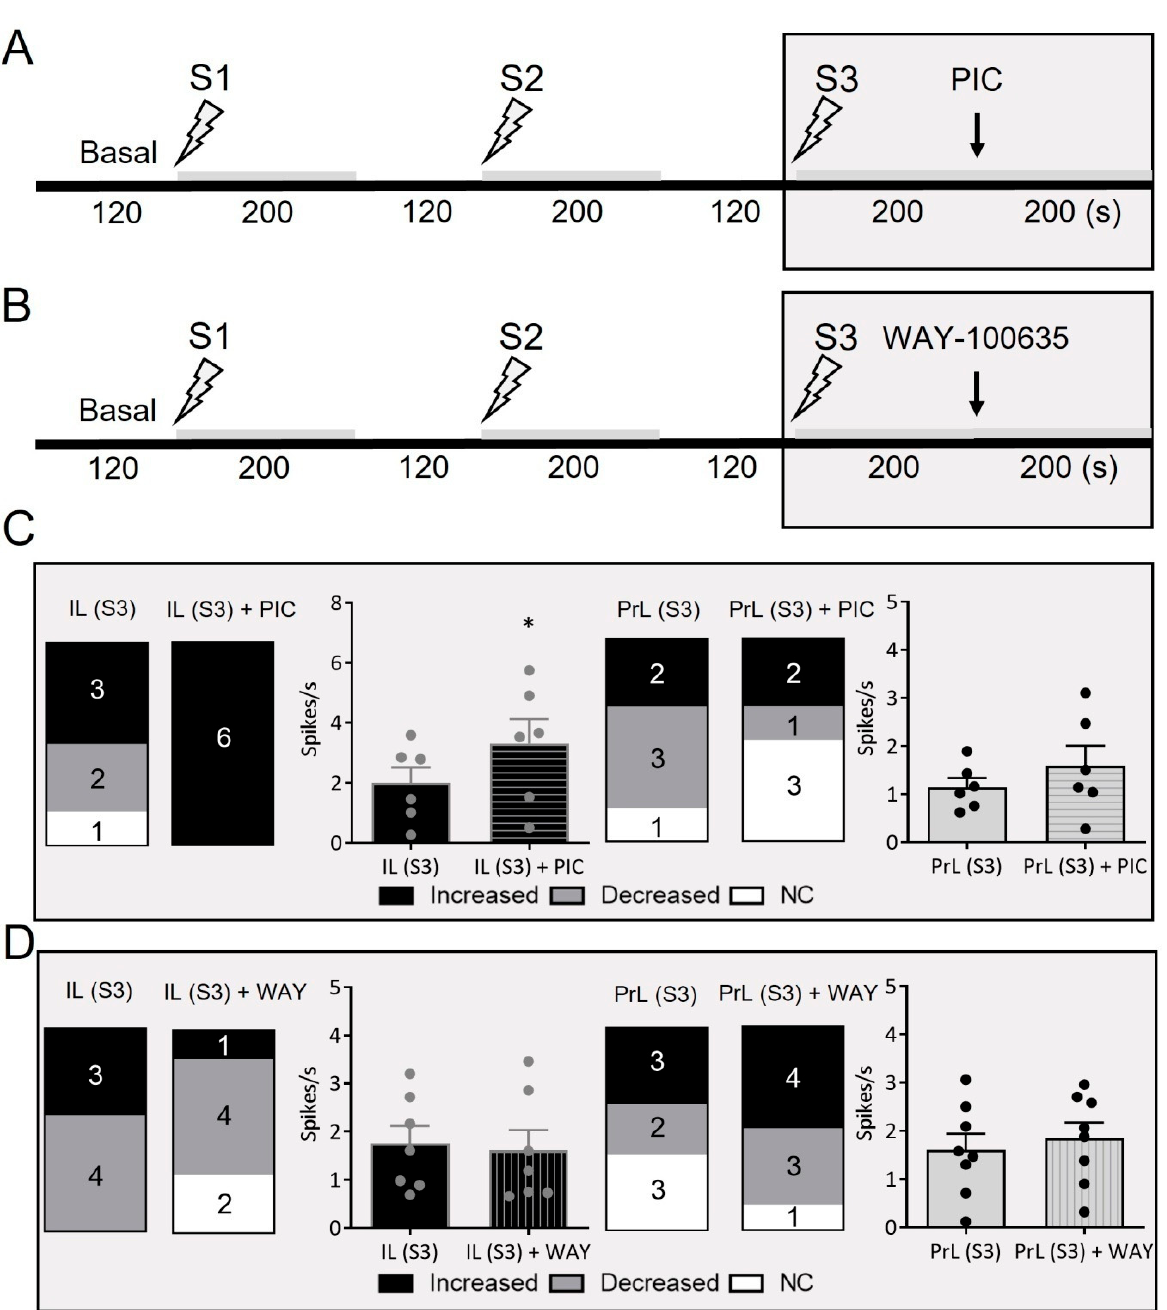
Figure 4. Involvement of 5-HT 1A and GABA A receptors in IL and PrL induced responses in DR 5-HT neurons. ( A , B ) Protocol used to examine the responses of DR 5-HT neurons to IL and PrL stimulation at increasing frequencies (S1: 0.9 Hz, 0.2 ms, 1.7 mA; S2: 10 Hz, 1 ms, 0.5 mA; S3: 20 Hz, 1 ms, 0.5 mA) before and during picrotoxinin (PIC, GABA A -R antagonist, 2 mg/Kg i.v.) ( A ) and WAY-100635 (5-HT 1A -R antagonist,10 µg/Kg i.v.) ( B ) administration. Note that both drugs were injected after S3, and the stimulation was maintained for at least 200 s more, to evaluate the effects of the drug. ( C , D ) Picrotoxinin (PIC) ( C ) and WAY-100635 ( D ) effects on IL- and PrL-induced responses under S3 conditions. Bars show the number of increased, decreased, and unaffected (NC) 5-HT neurons before and after PIC and WAY administration during S3 stimulation. Bar graphs indicate firing rate (spikes/s) for each stimulation site (IL and PrL) and drug (PIC and WAY-100635). Note that the GABA A receptor antagonist PIC (but not WAY-100635, a 5-HT 1A receptor blocker) totally changed the effects on serotonergic neuron activity induced by IL stimulation under S3 conditions, increasing their firing discharge (* p < 0.05 vs. IL